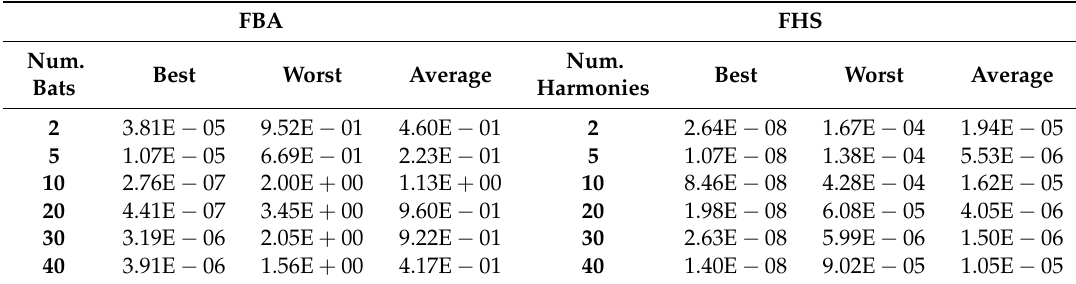
Table 14. Experiment results obtained for the Ackley function with the FBA and FHS algorithms. FBA FHS Num. Bats